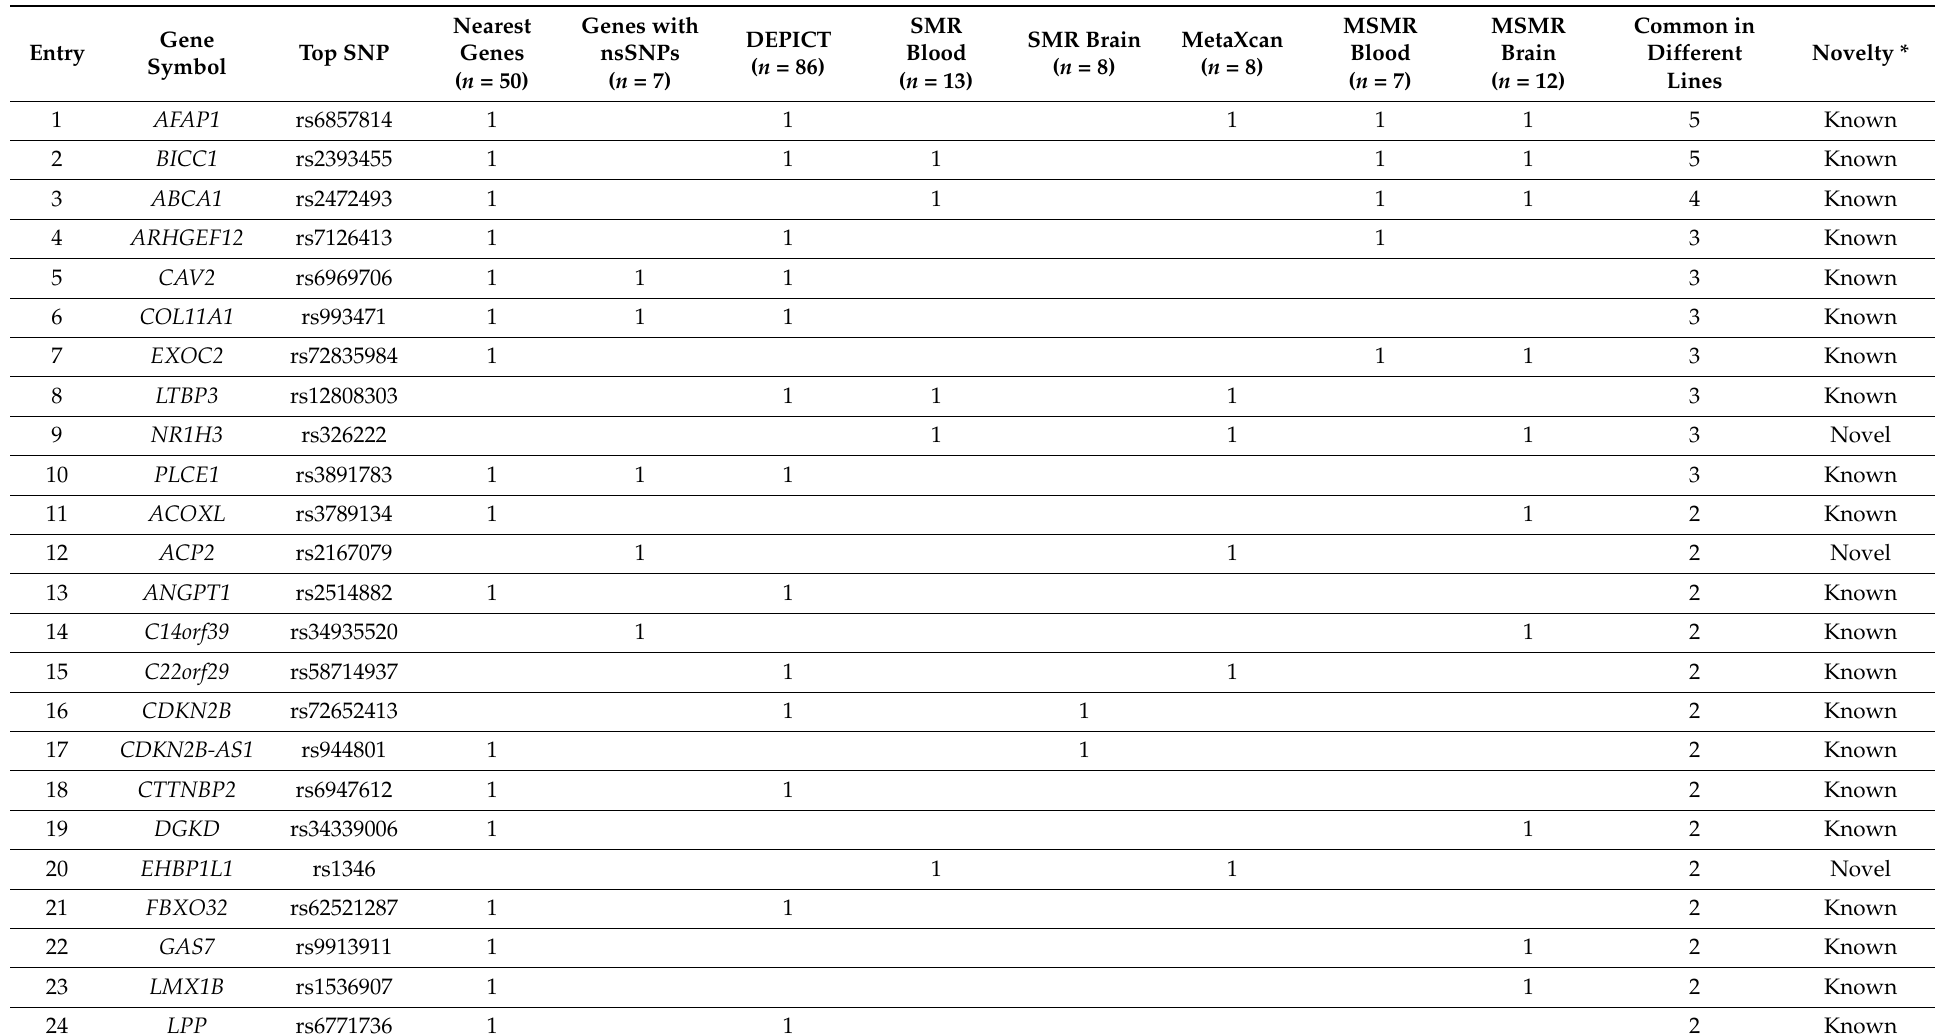
Table 2. Number of prioritized genes per pipeline and their novelty in